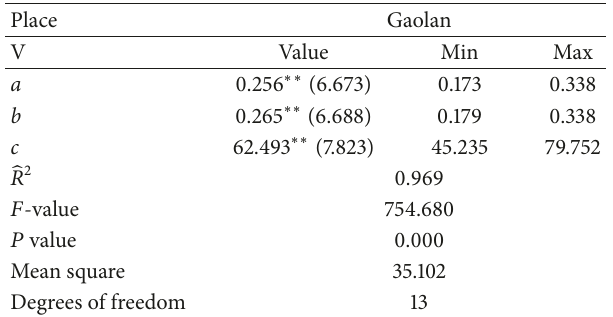
Table 11: Fitting parameters of empirical model on G-7 by sieve- pipette method.